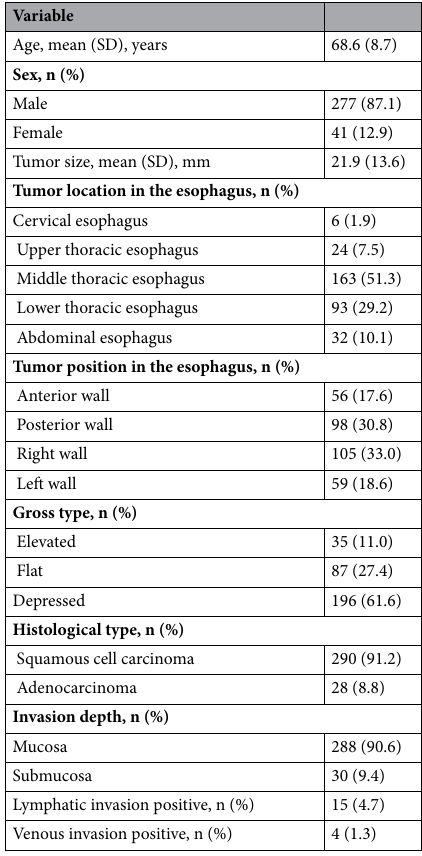
Table 1. Baseline clinicopathological characteristics of all cases treated by endoscopic submucosal dissection (n = 318). SD Standard